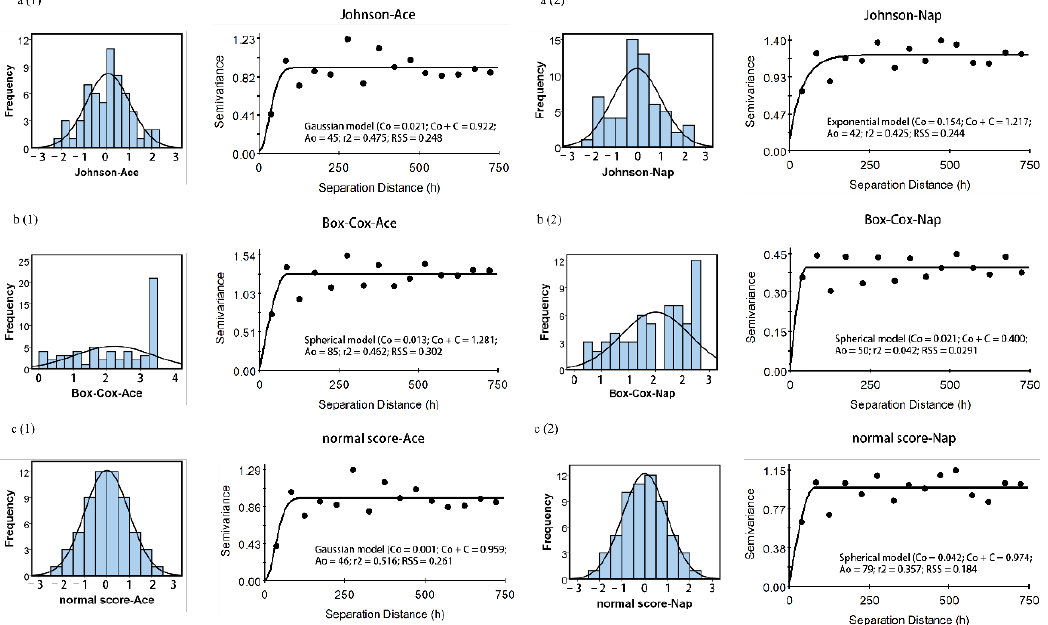
Figure 2. Left : Histograms of the transformed soil Ace ( a1 , b1 , c1 ) and Nap ( a2 , b2 , c2 ) concentrations: (a) Johnson transformed data; (b) Box-Cox transformed data; (c) normal score transformed data. Right : Experimental semivariograms and fitted parameters corresponding to the transformed data.